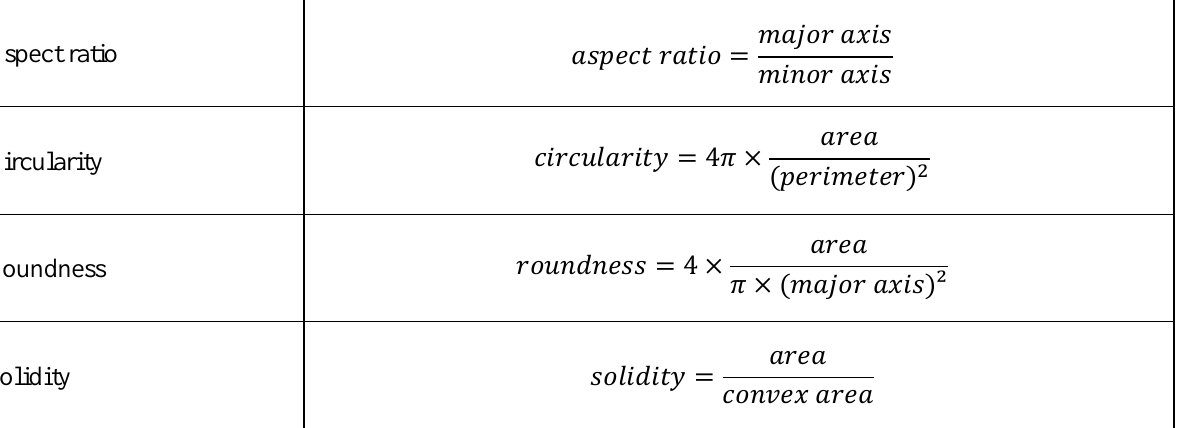
Table 1. Formulae for shape descriptors calculated using ImageJ (Ferreira & Rasband 2012). Major and minor axes are for the best fit ellipse. Convex area is the area of the smallest convex shape that would contain the target